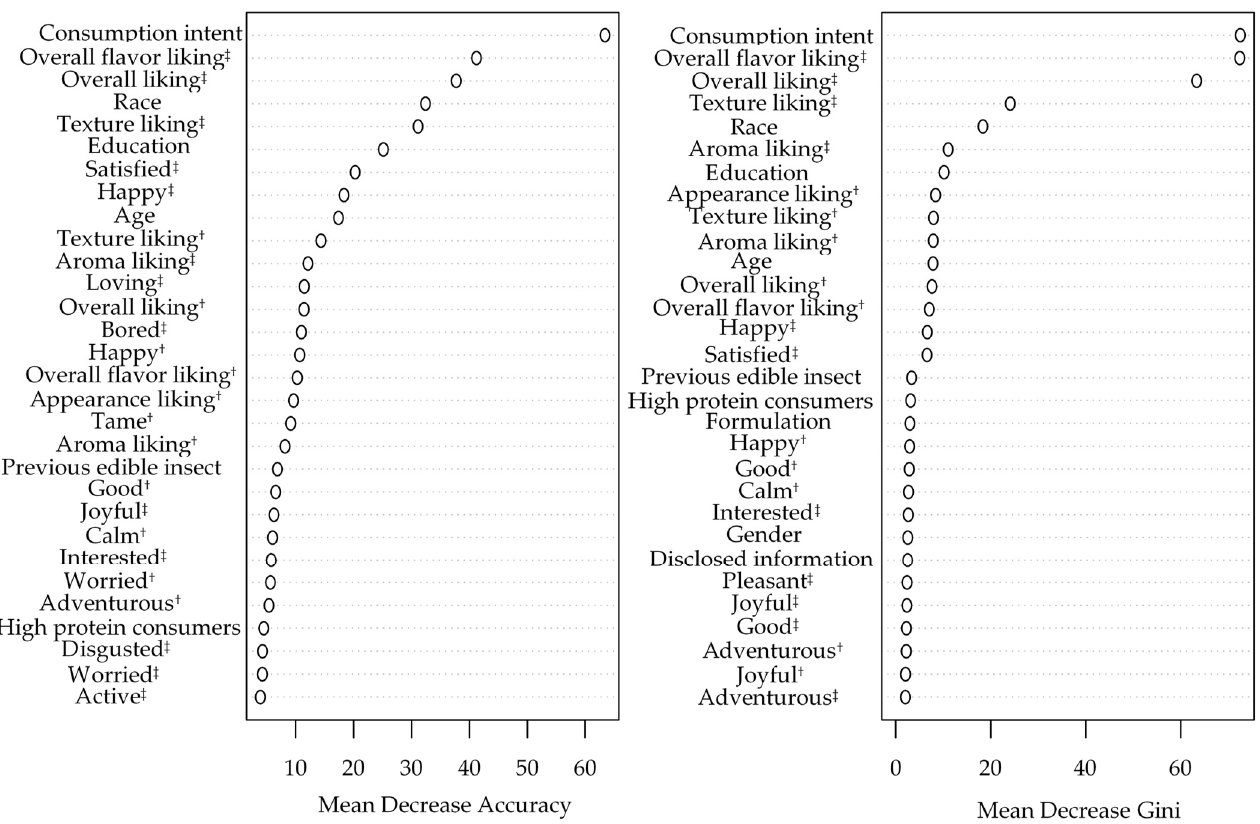
Figure 8. Random forest classifier variables importance plots for purchase intent (PI) prediction. † Before-tasting condition; ‡ after-tasting condition.